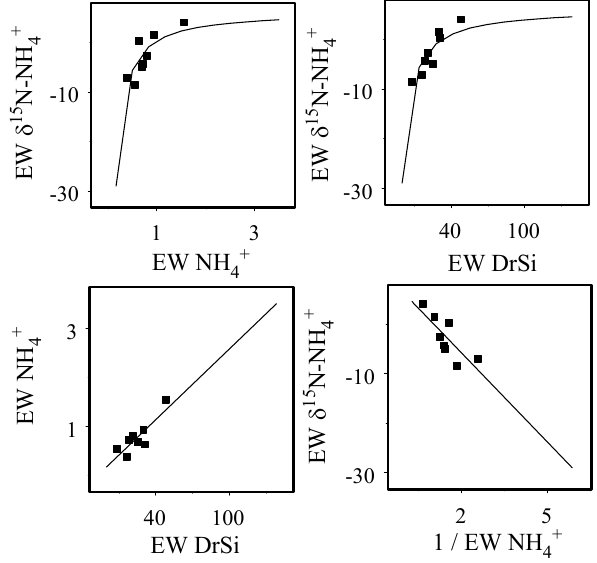
Fig. 4. Comparison between measured field data (symbols) and esti- mated values (line) based on the mixing of two hypothetical sources with the following characteristics: source A, DRSi=0µmolL − 1 ; NH + =0.17, δ 15 N-NH + = − 29.5‰; source B, DRSi=120µmolL − 1 ; 4 4 NH + =3.17, δ 15 N-NH + 4 4